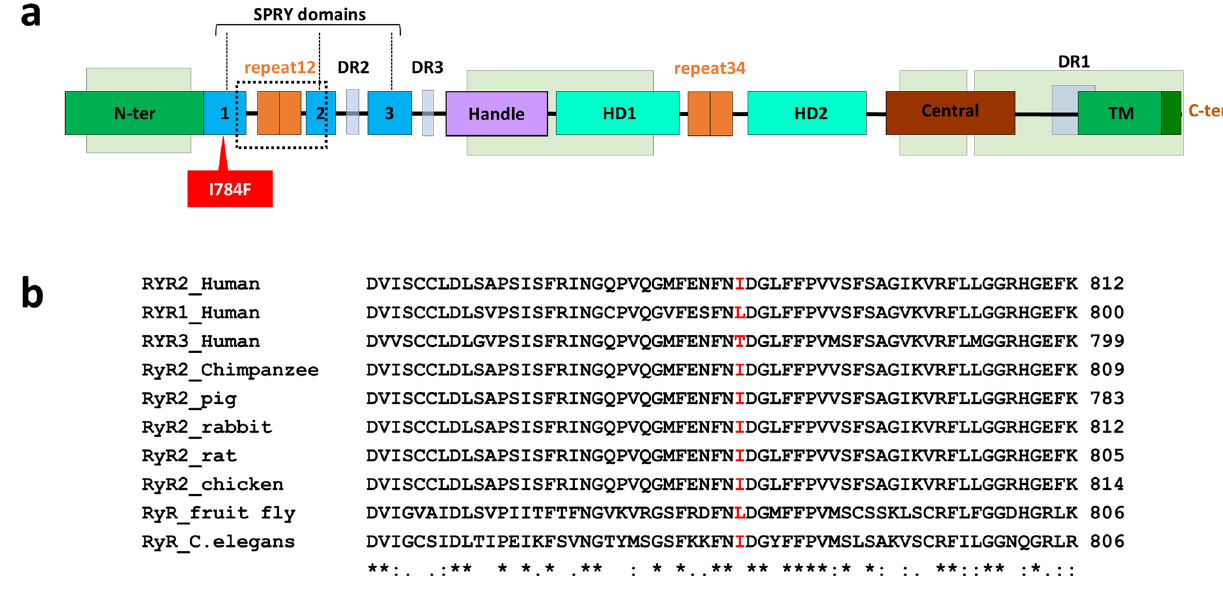
Figure 2. Localisation and evolutionary conservation of Ile784 in the RyR2 SPRY1 domain. ( a ) Schematic representation of RYR2 domains 20,30 . Dashed square shows the FKBP12.6 binding site to repeat12, SPRY1 and SPRY2 domains. Light green squares represent CPVT mutation hotspots: The N-terminal domain comprises amino acids 66-466 (CPVT-I), the central domain comprises amino acids 2246-2534 (CPVT-II) and the channel region comprises amino acids 3778-4201 (CPVT-III) and 4497-4959 (CPVT-IV). The I784F variant is located outside of the four hotspots where most previously reported mutations have been identified. N-ter: N-terminal; HD: Helical domain; TM: Transmembrane; DR: Divergent Region. ( b ) Sequence alignment of RyR2 proteins from several species and human RyR1 and RyR3 isoforms. It is noteworthy that the isoleucin is conserved in Caenorhabditis elegans (I2HAA6_CAEEL, encoded by Nevertheless, when compared to basal conditions, the response of RyR2-I784F cells to cAMP treatment was lower than that of the RyR2-WT cells. Indeed, at 0.1 mM Ca 2+ , the percentage of oscillating cells was increased up to 5.52-fold in WT cells vs 2.11-fold in I784F cells (p = 0.0067). A difference was also observed at 0.5 mM, with a 1.64-fold increase in WT cells vs 1.24-fold in I784F expressing cells (p = 0.0272). By contrast, no difference was found at 1 mM (1.26-fold for WT and I784F; p = 0.0743). These results show that the expression of the I784F variant increases the percentage of oscillating cells under basal conditions at 0.1 mM and 0.5 mM Ca 2+ , compared to WT. However, cAMP treatment induces a milder increase in percentages of oscillating cells in I784F cells, especially at low Ca 2+ concentrations. These data suggest that the presence of the I784F variant may alter the response of RyR2 to cAMP. RyR2‑I784F variant exhibits a higher spontaneous Ca 2+ oscillation rate. We then assessed the effect of RyR2-I784F variant on the store-overload induced Ca 2+ release (SOICR) which can be observed as spontaneous Ca 2+ oscillations in transfected HEK293 cells. Using a two-way ANOVA test, we found that Ca 2+ oscillation frequencies differed as a function of expressed variant (RyR2-I784F vs RyR2-WT; p < 0.0001), Ca 2+ concentrations (p < 0.0001) and cAMP stimulation (p < 0.0001) with strong relationship between Ca 2+ concen- tration and cAMP treatment (Fig. 3b,c). RyR2-I784F expressing cells exhibited an increase in oscillation frequencies compared to RyR2-WT cells under basal conditions (p = 0.0203) and after cAMP treatment (p = 0.0012), especially at higher Ca 2+ concentra- tions. Indeed, while there was no significant difference at 0.1 mM under basal conditions (0.40 ± 0.001 for I784F vs 0.33 ± 0.004 for WT) and after cAMP treatment (0.45 ± 0.001 for I784F vs 0.43 ± 0.009 for WT) between the two types of cells, the RyR2-I784F cells displayed a significant increase in oscillation frequencies at 0.5 mM of Ca 2+ both under basal conditions and after cAMP treatment (basal: 0.53 ± 0.007 vs 0.45 ± 0.007. cAMP: 1.02 ± 0.017 vs 0.86 ± 0.019; p < 0.0001). The oscillation frequencies of RyR2-I784F were also significantly enhanced at 1 mM of Ca 2+ under basal conditions and after cAMP treatment (basal: 0.59 ± 0.007 vs 0.54 ± 0.007. cAMP: 1.16 ± 0.022 vs 1.02 ± 0.025; p < 0.0001). Moreover, oscillation frequencies increased after cAMP treatment, both in RyR2-WT and RyR2-I784F (both p < 0.0001) expressing cells, whatever the Ca 2+ concentrations. RyR2‑I784F effect on caffeine‑induced Ca 2+ release. Next, we aimed to determine whether the increase in oscillation frequencies impacts the total Ca 2+ store. Total Ca 2+ release was induced by the addition of 10 mM of caffeine, a known enhancer of the open probability of RyR2. The Ca 2+ store content was estimated by measuring the amplitude of caffeine-induced Ca 2+ release at 0.5 mM of Ca 2+ (Fig. 4a,b). Ca 2+ release in response to caffeine challenge was a function of the expressed variant (p < 0.0001) and cAMP treatment (p < 0.0001).